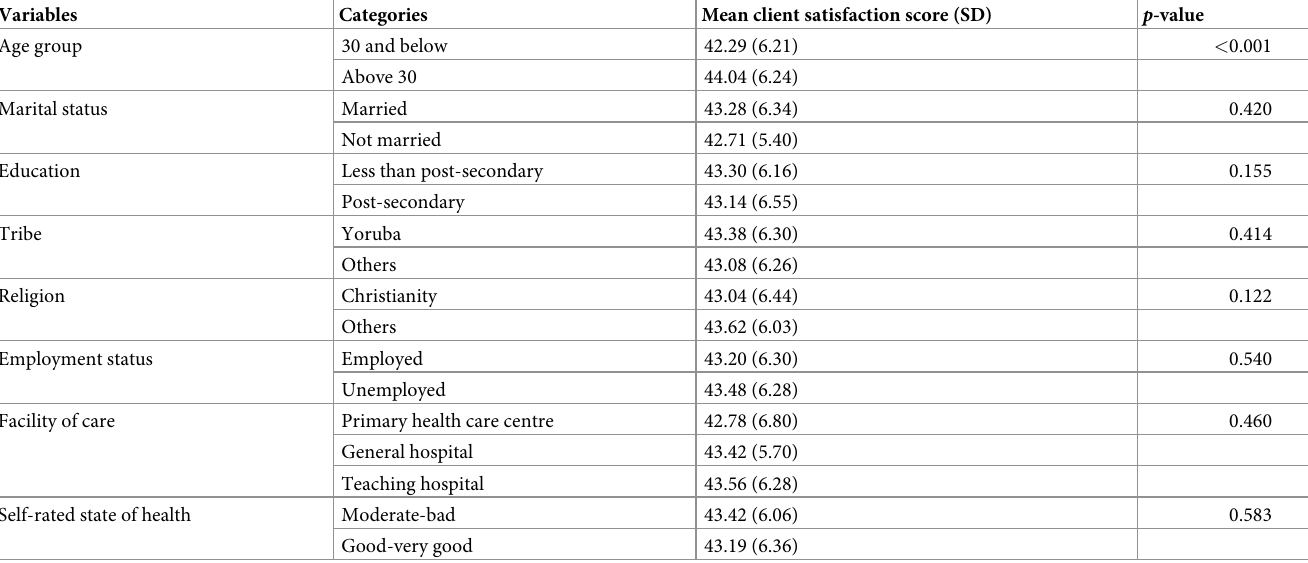
Table 3. Bivariate analysis of personal characteristics and clients’ satisfaction with RMNCH services during the COVID-19 outbreak in